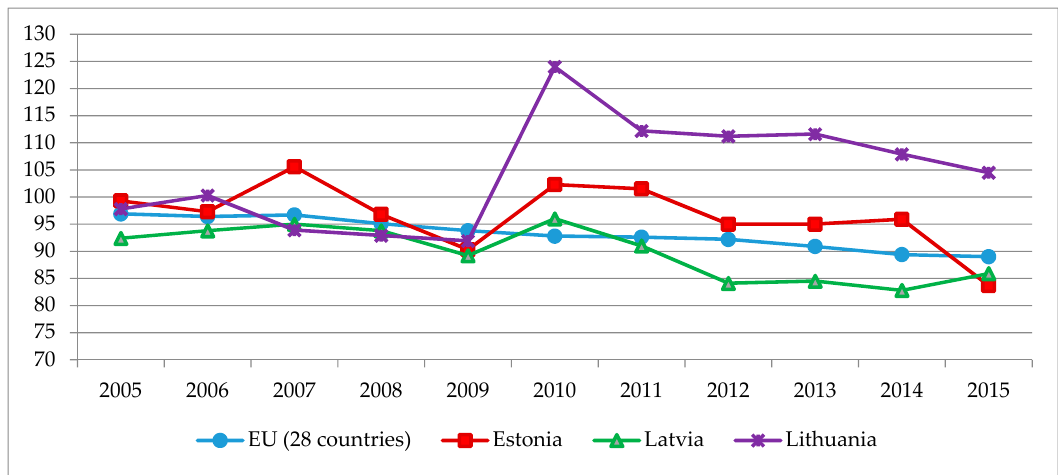
Figure 12. Carbon intensity of energy consumption; index 2000 = 100.